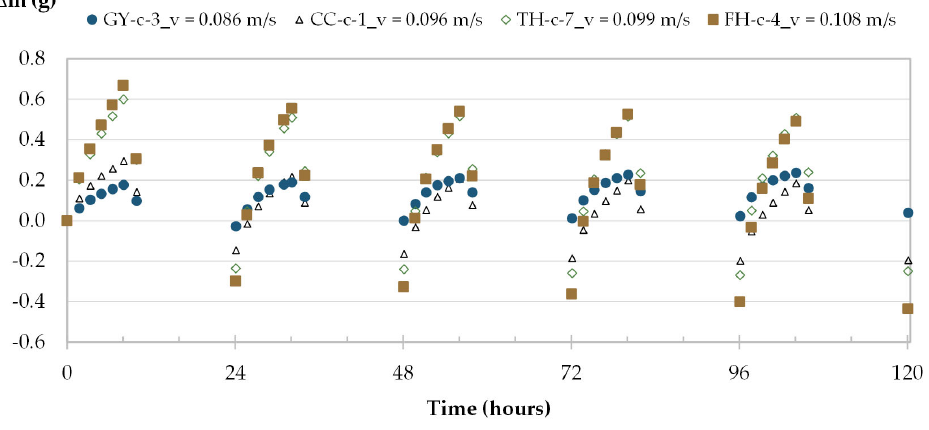
Figure 6. Moisture uptake and release for one specimen of each material along test 1 of MBV. The MBV obtained from the three specimens of each material are 0.53 g/(m 2 .%RH) for GY, 1.23 g/(m 2 .%RH) for CC, 2.12 g/(m 2 .%RH) for TH and 2.38 g/(m 2 .%RH) for FH.